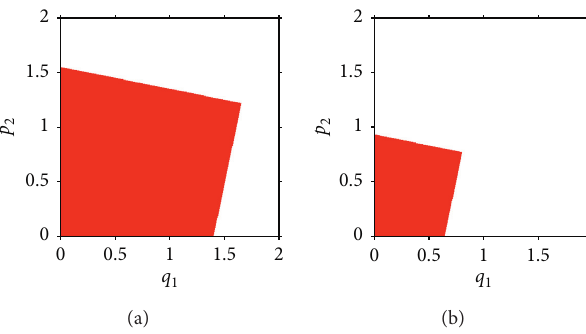
Figure 11: Basins of attraction of the dynamic system (12). (a) α � β � 0 . 5. (b) α � β � 1 .